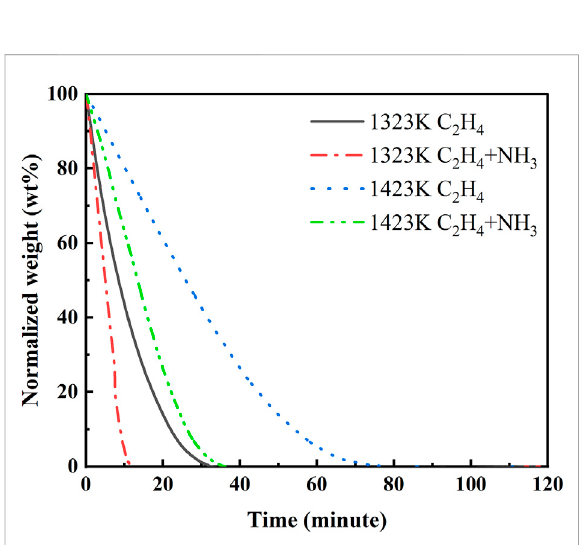
FIGURE 2 Oxidationcurvesfor differentpyrolysis conditions generating carbon soot particles at 500 °